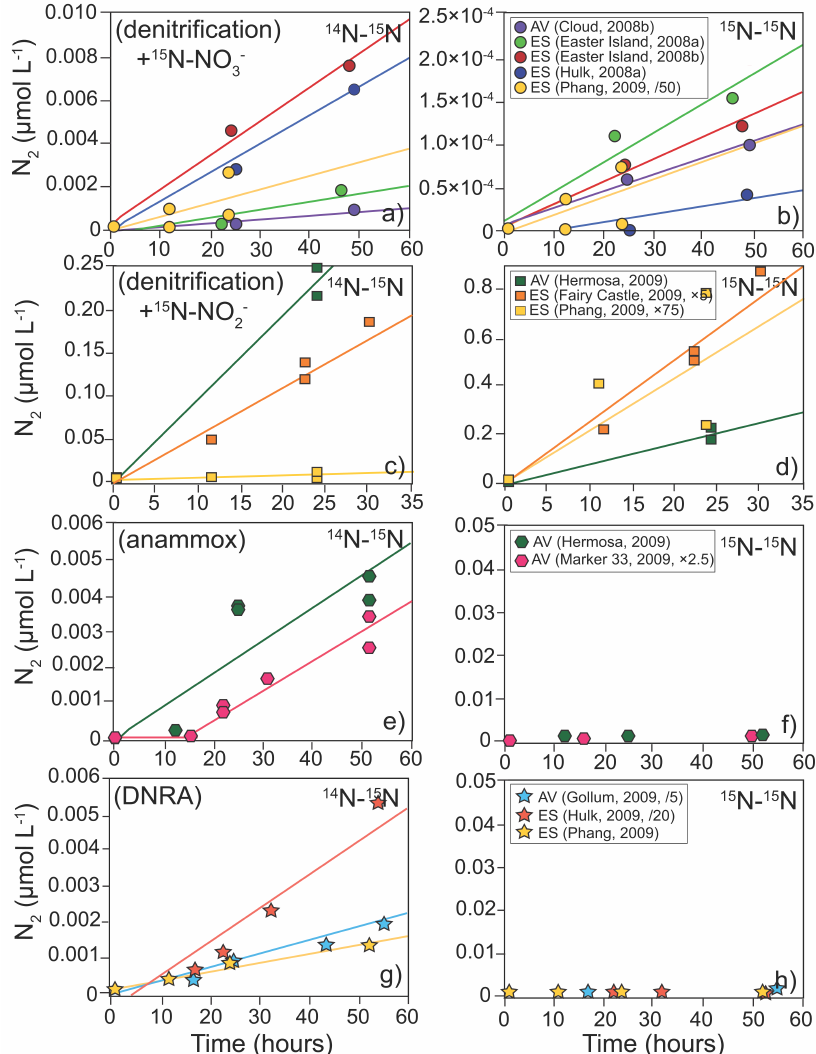
Fig. 2. Production of 14 , 15 N 2 and 15 , 15 N 2 over time for selected 15 N-labelled incubations: addition of 15 NO − (e, f) and 15 NO − followed by the addition of hypobromite (see text for more detail) (g, h) to measure potential denitrification (a, b, c, d) , 3 anammox (e, f) , and DNRA (g, h) rates in diffuse hydrothermal vent fluids. All N 2 values were normalised to 0µmoll − 1 at time t = 0. Values for duplicate measurements are shown for all 2009 incubations. Values at some sites were multiplied or divided (numbers next to vent names and sampling years in legends) to fit on the same